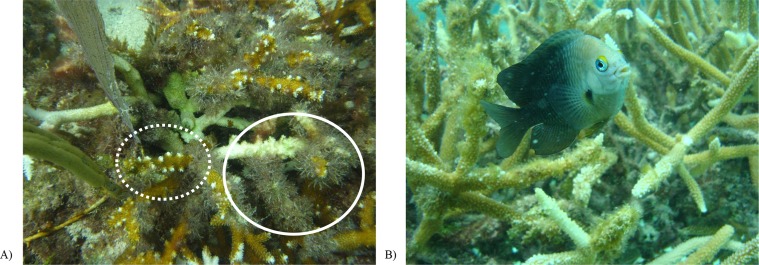
Colony of Acropora cervicornis with examples of (a) a damselfish algal lawn (solid circle) and chimneys formed by damselfish bites (dashed circle), and (b) a resident farming damselfish, Stegastes planifrons.Chimneys are formed as the coral attempts to recover tissue damaged due to repeated biting by damselfishes.